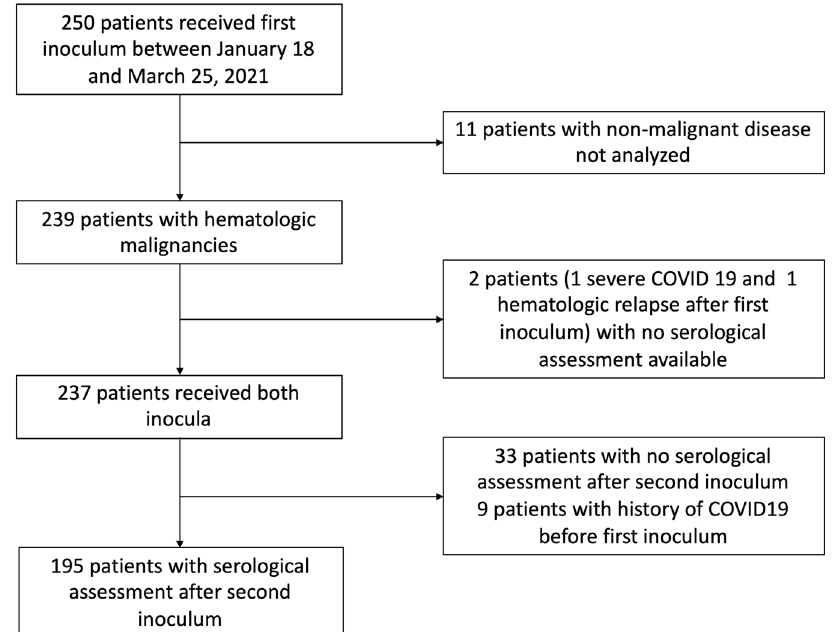
Fig. 1 Patients ’ population. Patients with hematological malignancies assessed for response after vaccination with the BNT162b2